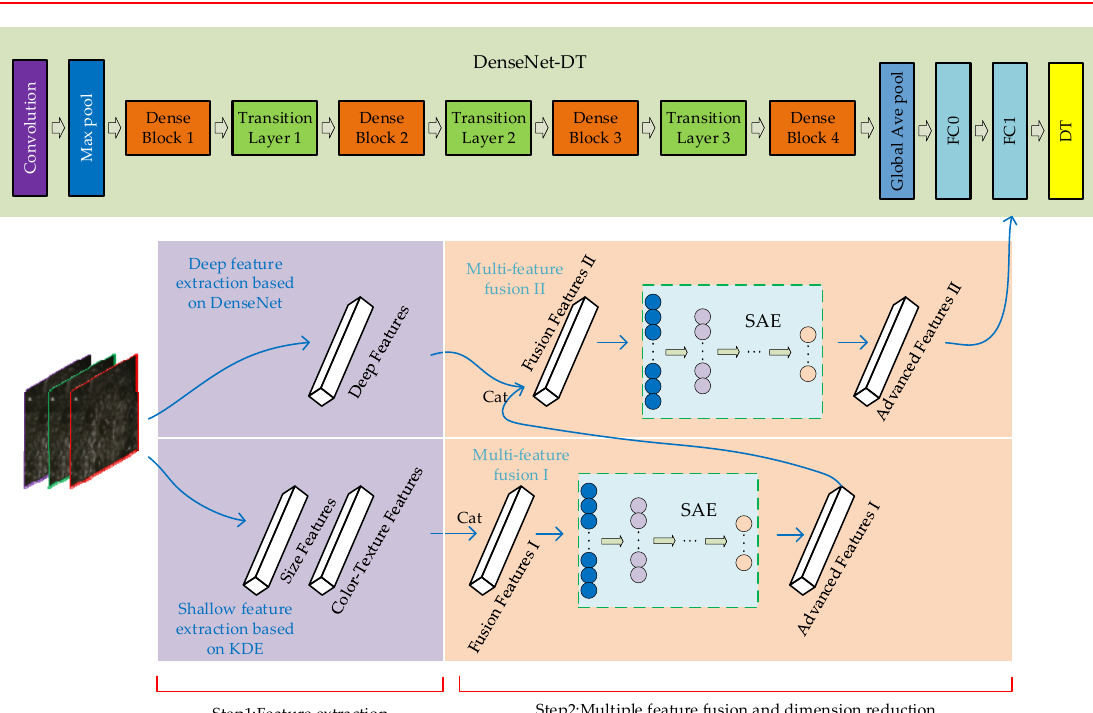
Figure 3. The working condition recognition framework of DSFF-DenseNet-DT.